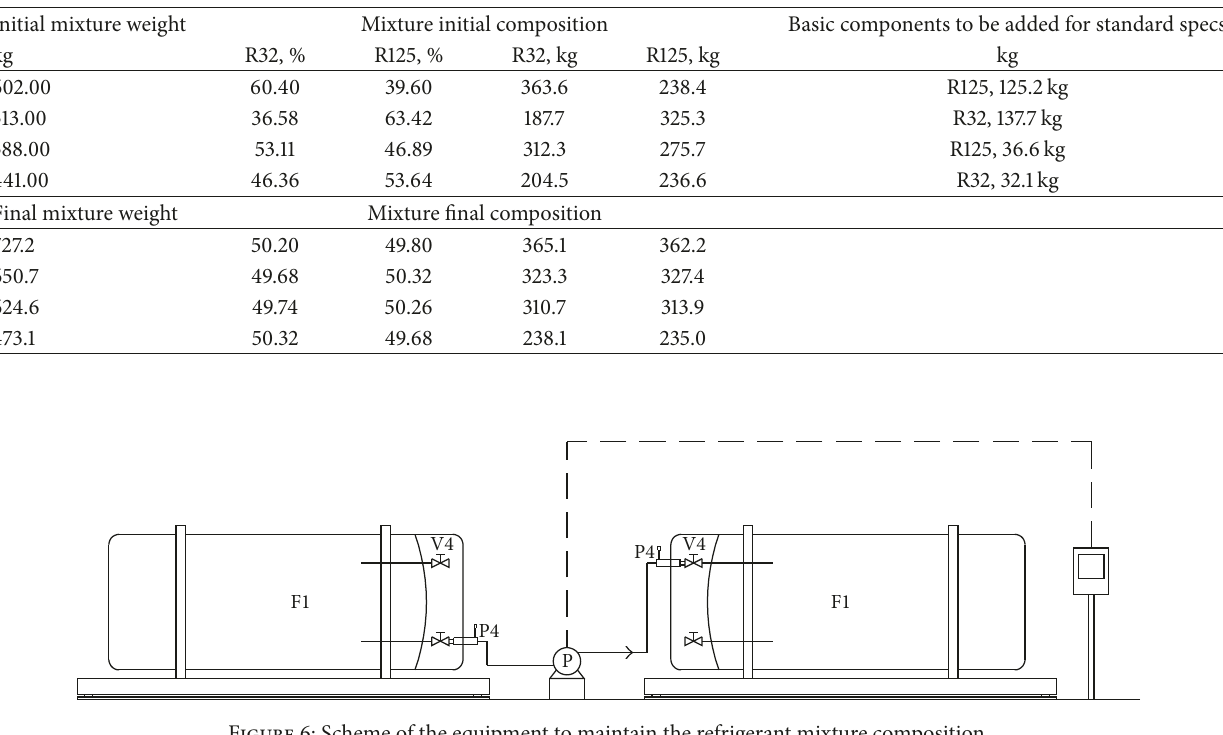
Table 6: Gas analysis before and after regeneration.